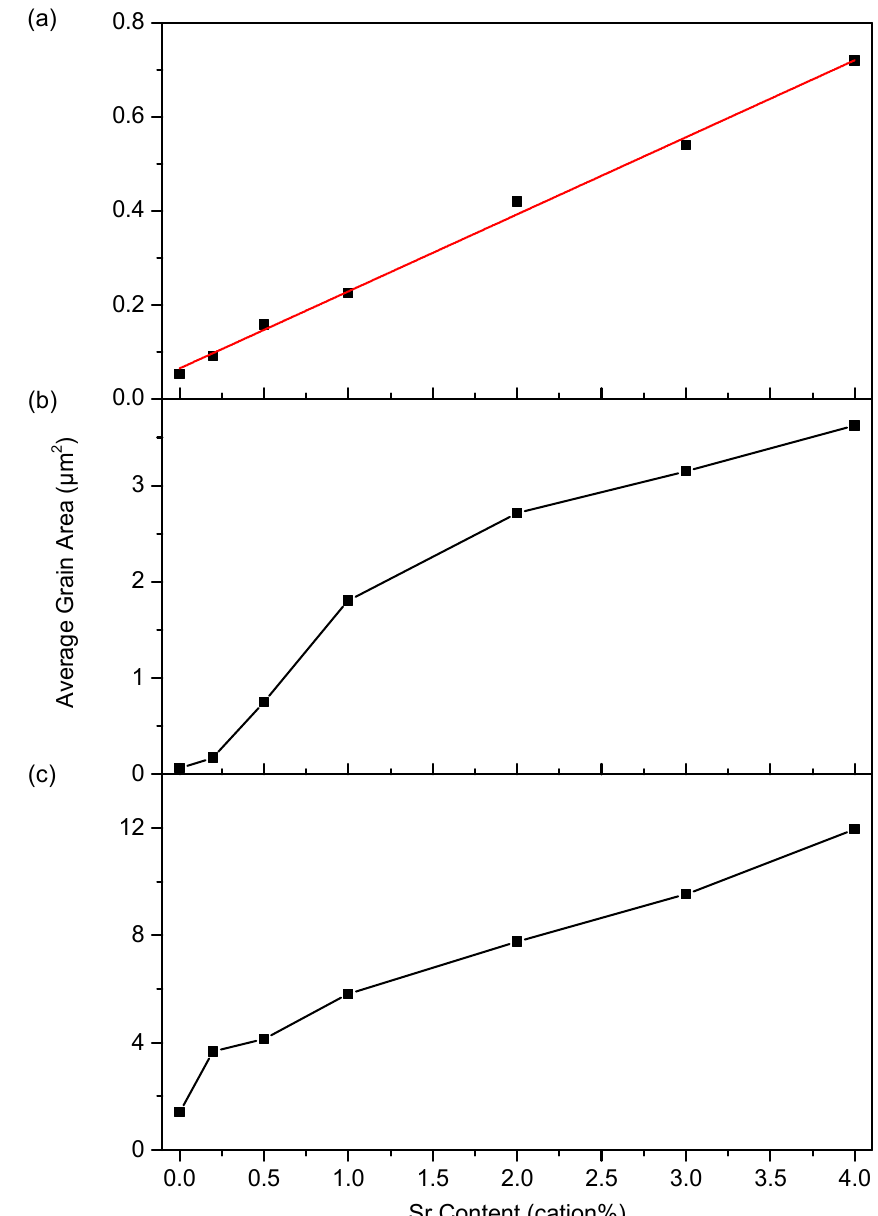
Figure 4. Plots of average cross-sectional grain area against Sr content for all Ce 0.8 − x Sm 0.2 Sr x O 2 − δ samples sintered for 4 h at ( a ) 1250 ◦ C, ( b ) 1350 ◦ C and ( c ) 1450 ◦ C. Plot ( a ) shows a linear fit of the data, and plots ( b , c ) show a joining line as a guide to the eye.